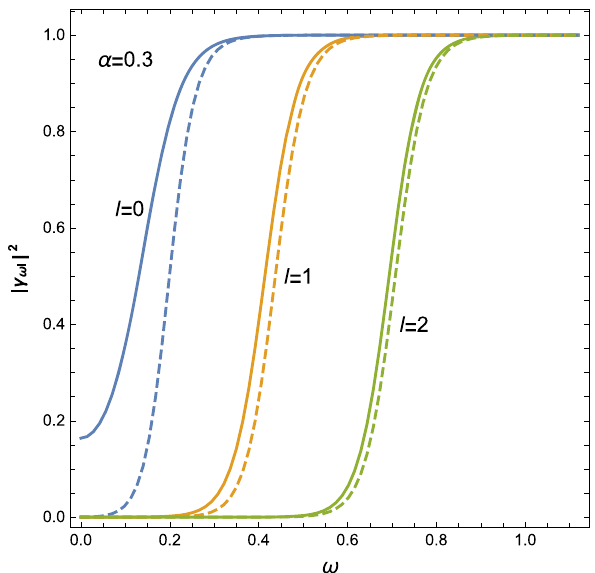
Fig. 3 Effects of ξ on the greybody factor for different l . Solid lines for ξ = 0 and dashed lines for ξ = 0 . 3. We fix (cid:3) = 0 . 1 and α = 0 . 3 here